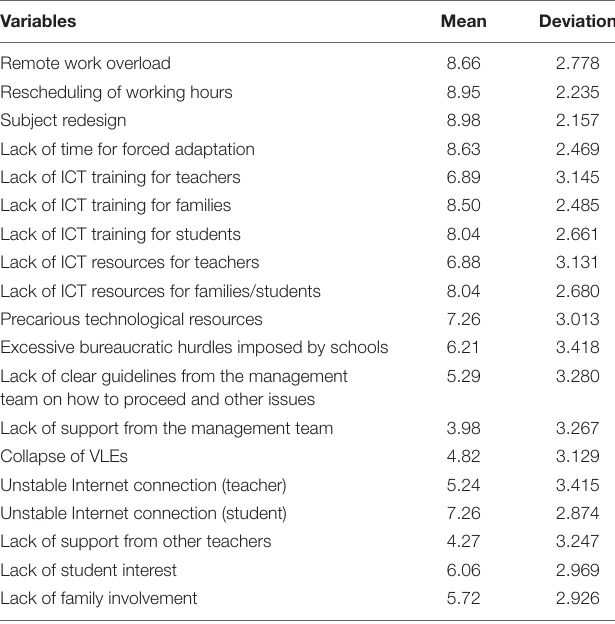
TABLE 4 | Impact on teachers’ professional